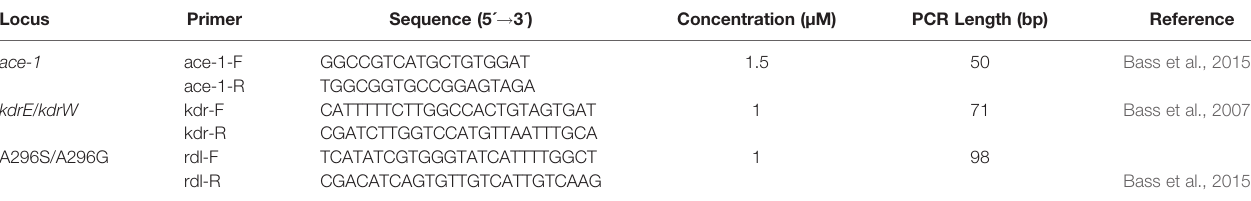
TABLE 1 | Multiplex PCR primers for detection of multiple insecticide resistance genes in An. gambiae .